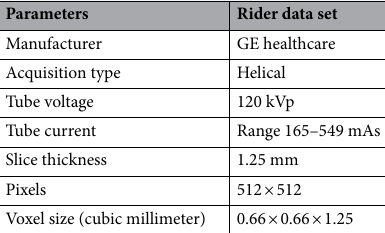
Table 4. The imaging protocol of the RIDER data